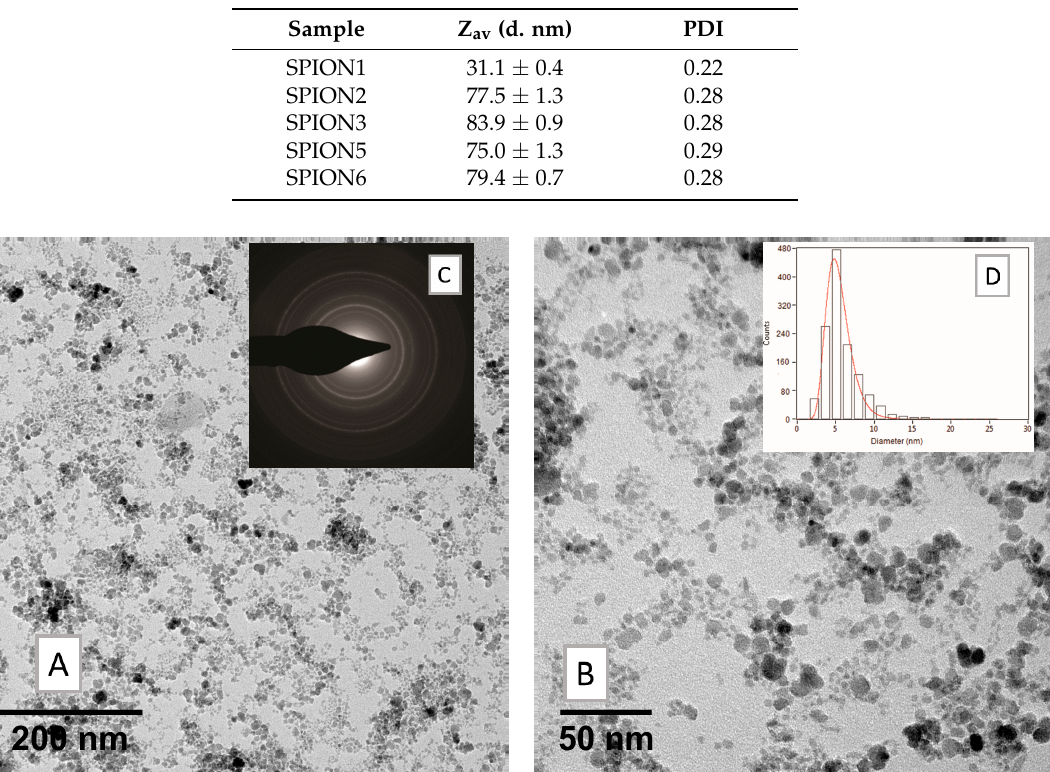
Figure 7. TEM measurements on nanocrystals of magnetite-oleate nanoparticles ( Fe 3 O 4 · OA, SPION1) ( A ) low and ( B ) high magnification bright field micrographs; ( C ) relevant selected-area electron diffraction (SAED) pattern and ( D ) size distribution histogram of the nanoparticles ensemble.